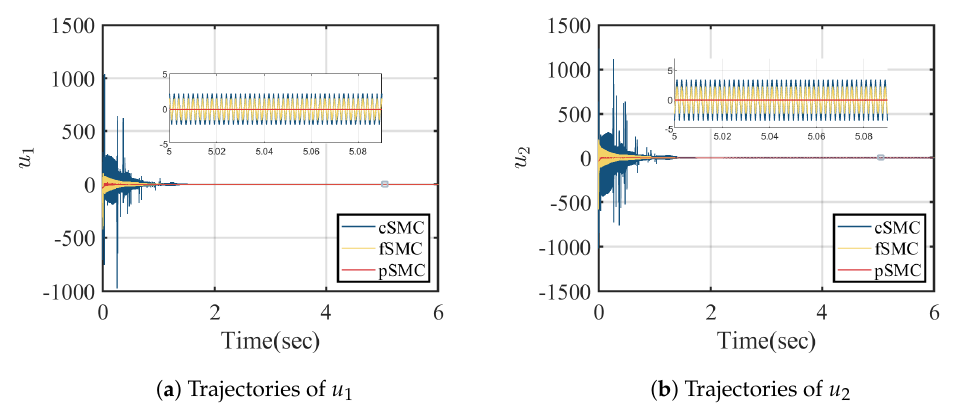
Figure 17. The trajectories of control variables u 1 and u 2 with a far initial state in control when ρ b = 0.6: cSMC (Blue solid line), fSMC (Yellow solid line) and pSMC (Red solid